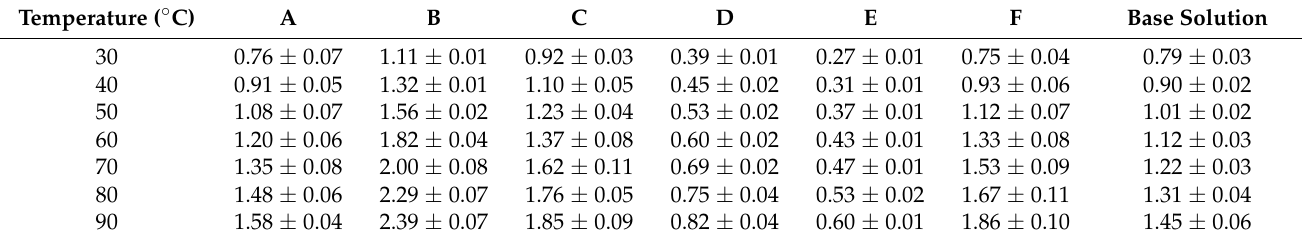
Types of commercialized senior-friendly foods: soft diet (A and B), liquid food (C, D, and E), and pudding